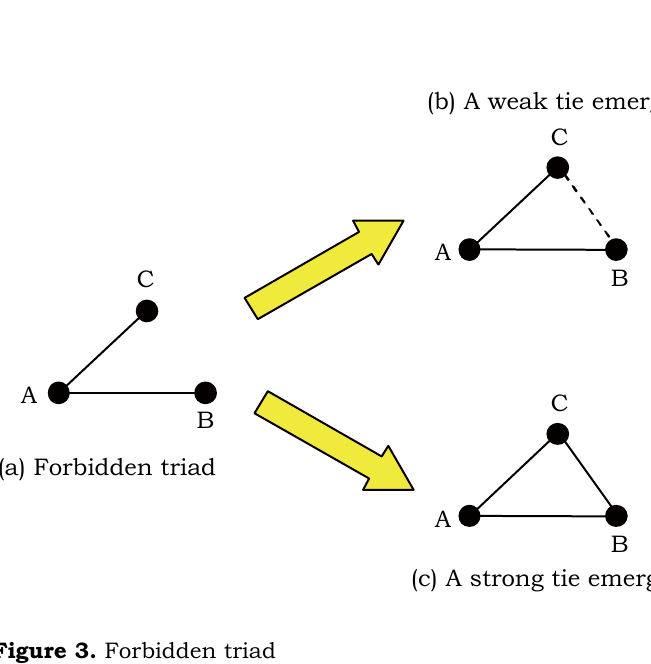
Figure 3. Forbidden